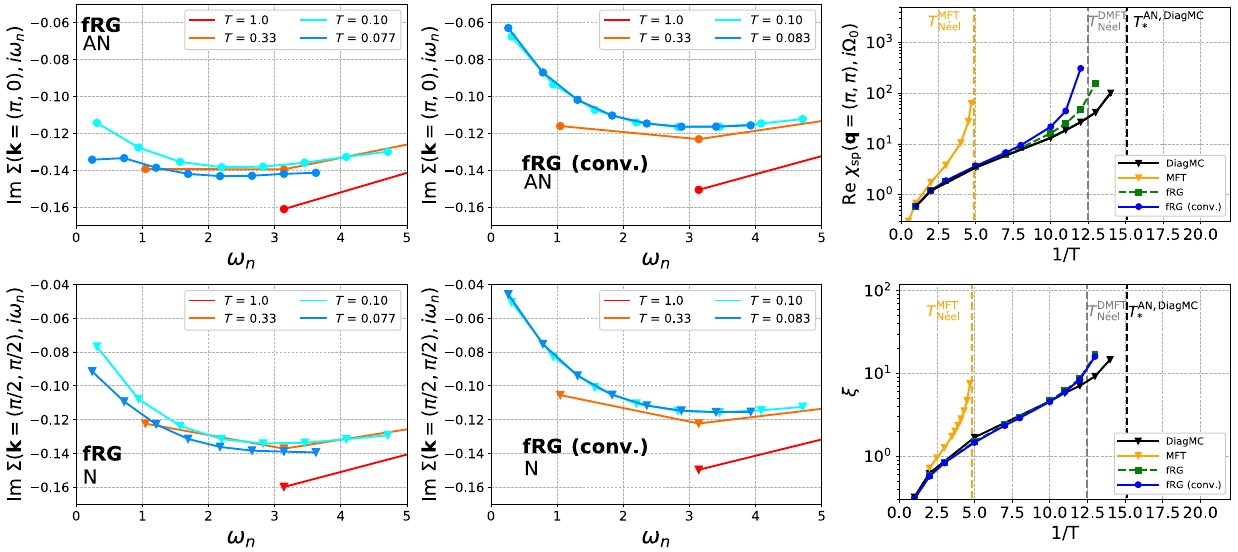
FIG. 39. Comparison of the imaginary parts of the self-energies at the antinode (upper panel) and node (lower panel) as a function of Matsubara frequencies calculated by using the scale derivative of the Schwinger-Dyson equation (fRG, left panels, presented in the main text) and by the conventional self-energy flow [fRG (conv.), middle panels]. In contrast to the results shown in Figs. 10 and 11, the reduced renormalization of the self-energy in fRG (conv.) leads to an enhanced spin susceptibility Re χ panel) and correlation length ξ (lower right panel). The self-energy implementation in the conventional flow does not capture the pseudogap